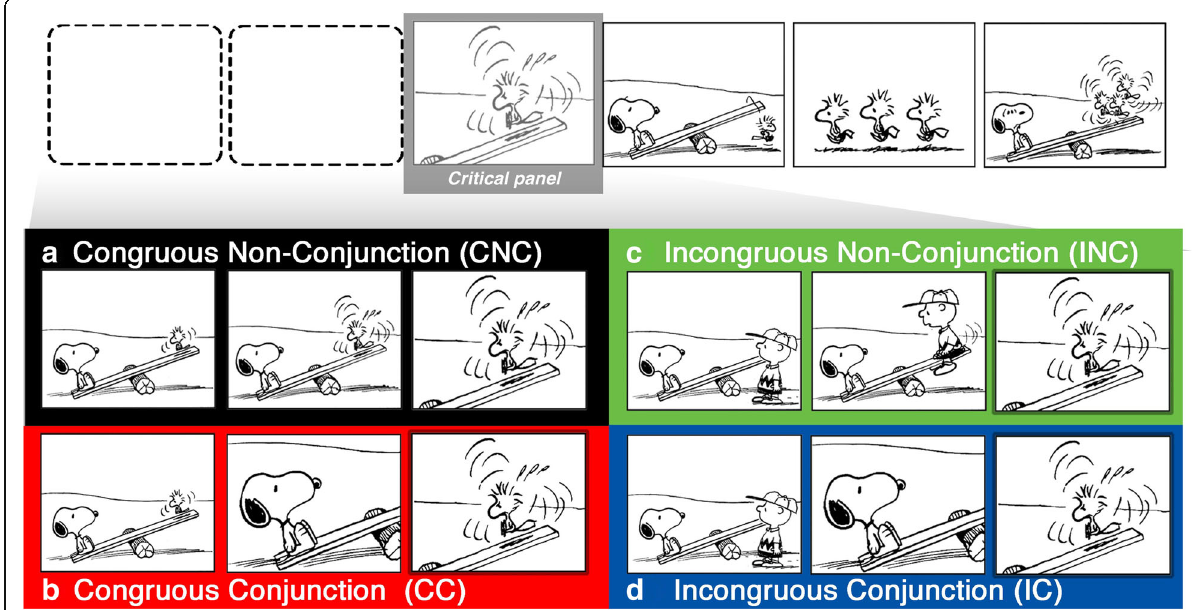
Fig. 3 Experimental sequence types crossing Conjunction with Congruity. a Congruous Non-Conjunction (CNC). b Congruous Conjunction (CC). c Incongruous Non-Conjunction (INC). d Incongruous Conjunction